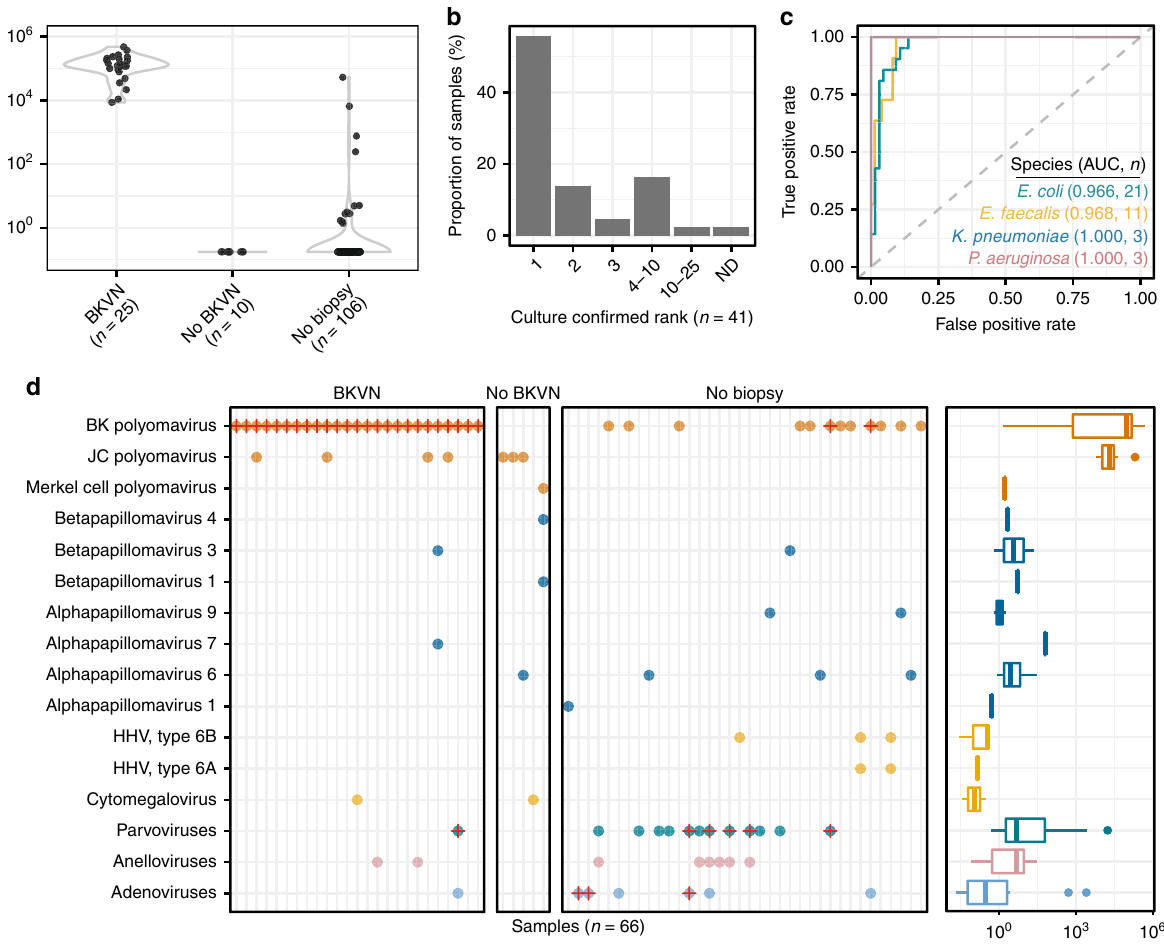
Fig. 2 Urinary cfDNA infectome screening. a Violin plots of BKV cfDNA sequence abundance (in RGE) for subjects with and without BKVN and untested subjects. b cfDNA rank order abundance for clinically reported organisms. In 60% of samples, the bacterial organism detected in culture was the most abundant component of the cfDNA urinary microbiome (rank 1). In one sample, the clinically reported agent was not detected (ND, R . ornithinolytica ). c ROC analysis of the performance of urinary cfDNA in identifying bacterial organisms (86 urine samples, AUC area under the curve, n number of positive cultures, see Supplementary Figure 1 for individual ROC curves for these and two additional bacteria). d Viral cfDNA was detected in 66 samples of the 141 samples. cfDNA reveals frequent occurrence of viruses that are potentially clinically relevant (left panel); crosses identify samples belonging to subjects who developed an infection of the corresponding viral agent. Right panel shows boxplots of the viral cfDNA abundance across all samples (right panel). Coloring of points and boxplots by viral taxonomic group; see Supplementary Data 2 –